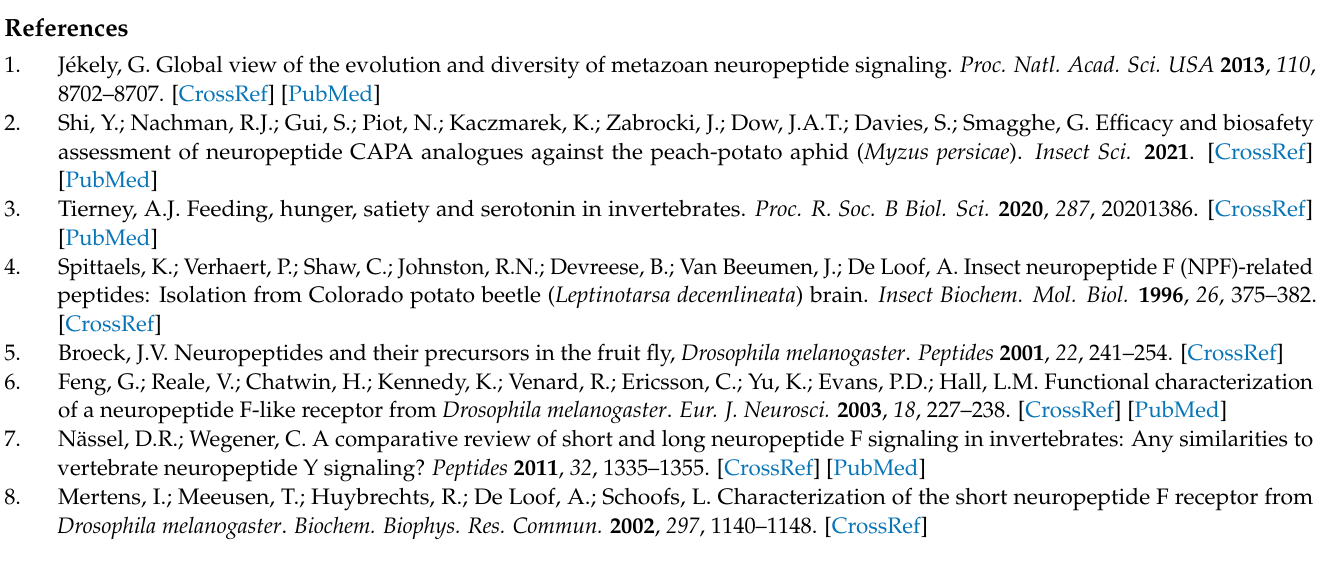
Table S3: Accession number of genes used for phylogenetic analysis, Table S4: The Ct values of qRT-PCR result obtained from the fed and starvation experiment. Table S5: Ct values of qRT-PCR obtained from the spatiotemporal expression and gene silencing experiment, Figure S1: Reverse transcription-polymerase chain reaction (RT-PCR) analysis of starvation with sNPF (A) and sNPFR (B) compared with the expression of ribosomal protein L7